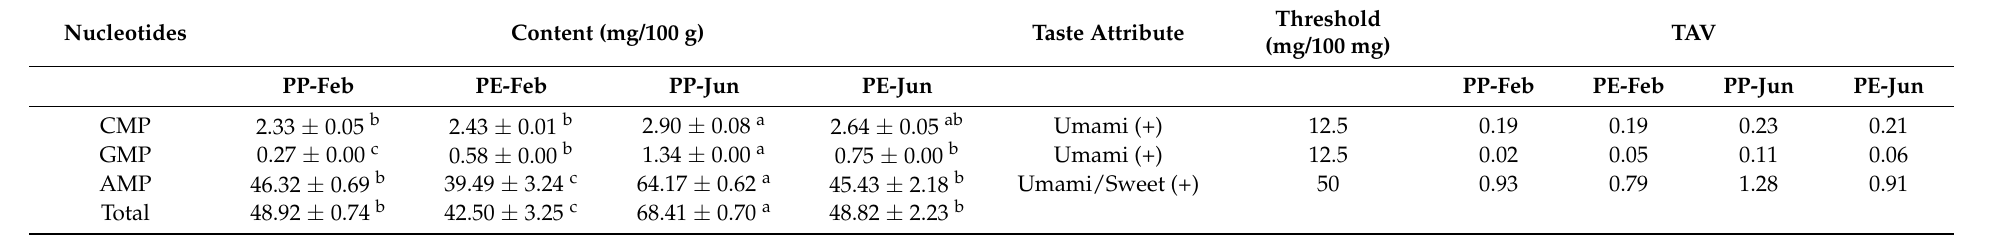
Table 7. The concentrations, taste thresholds and TAVs of 5 (cid:48) -nucleotides of two P. f. martensii selective strains at different seasons. Nucleotides